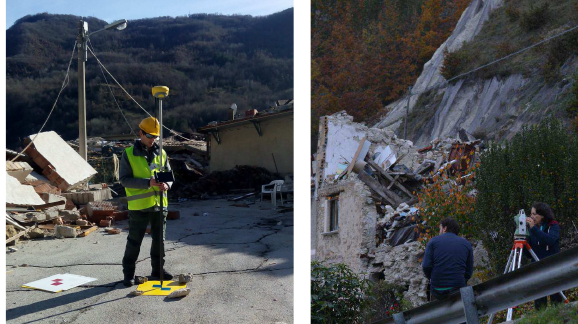
Figure 2. Survey operation with the Geomax Zenit 35 GNSS (left), Leica TS06 total station survey (right)